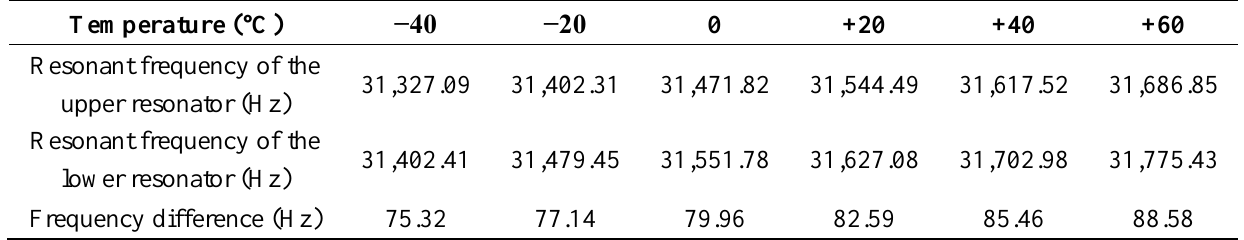
Table 8. The full temperature test result of the old